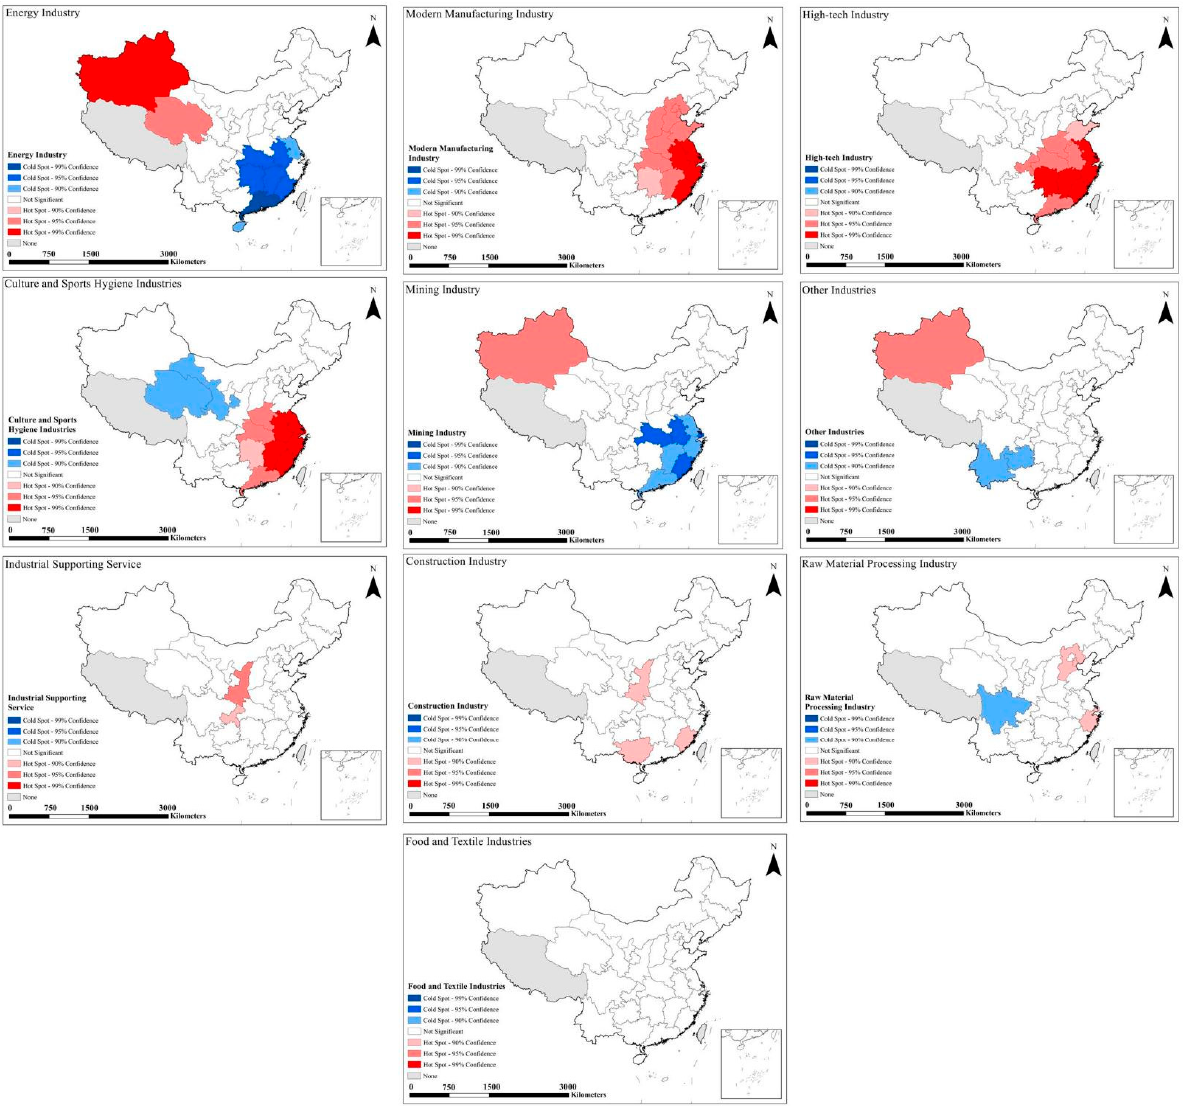
Figure 4. Cold and hot spot spatial distribution of industrial land supply in China’s provinces from 2010 to 2019.